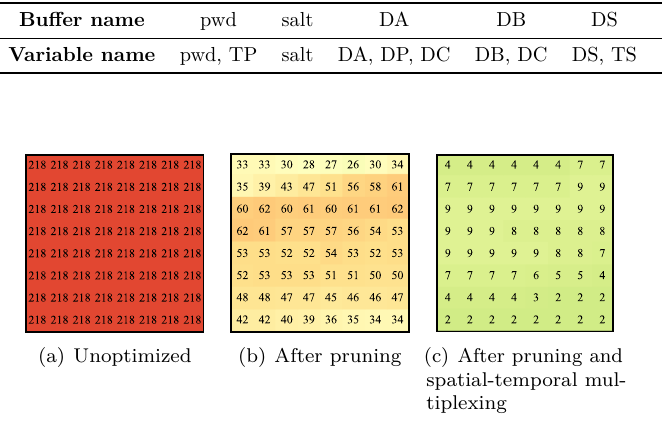
Table 3: Relationship between the variables and the buffers they use.